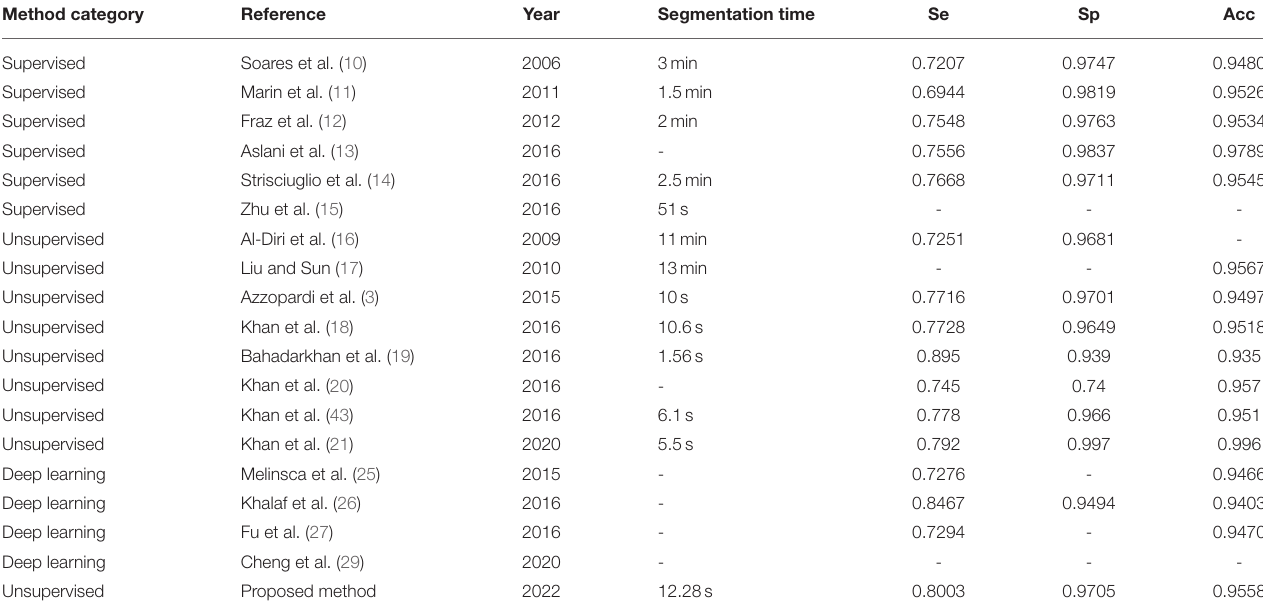
TABLE 7 | Comparison with other methods